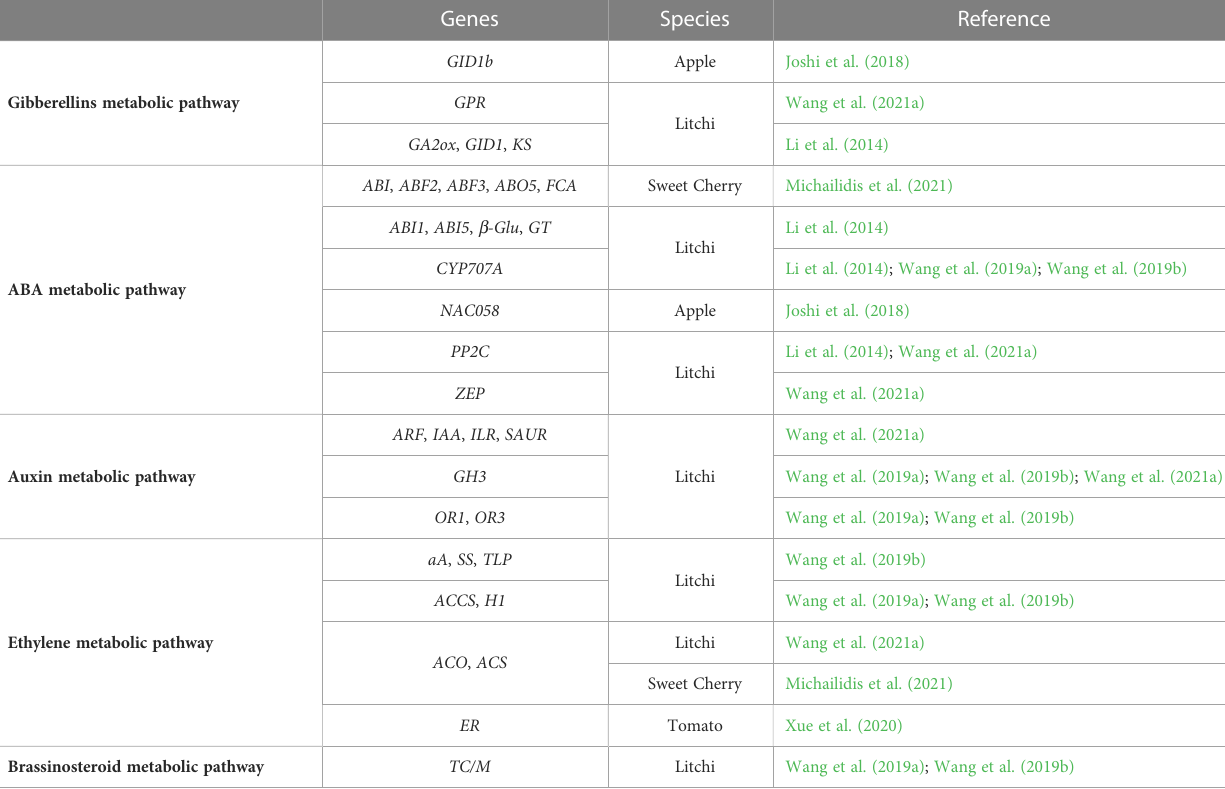
TABLE 5 Potentially cracking-related genes involved in fruit hormone metabolisms.